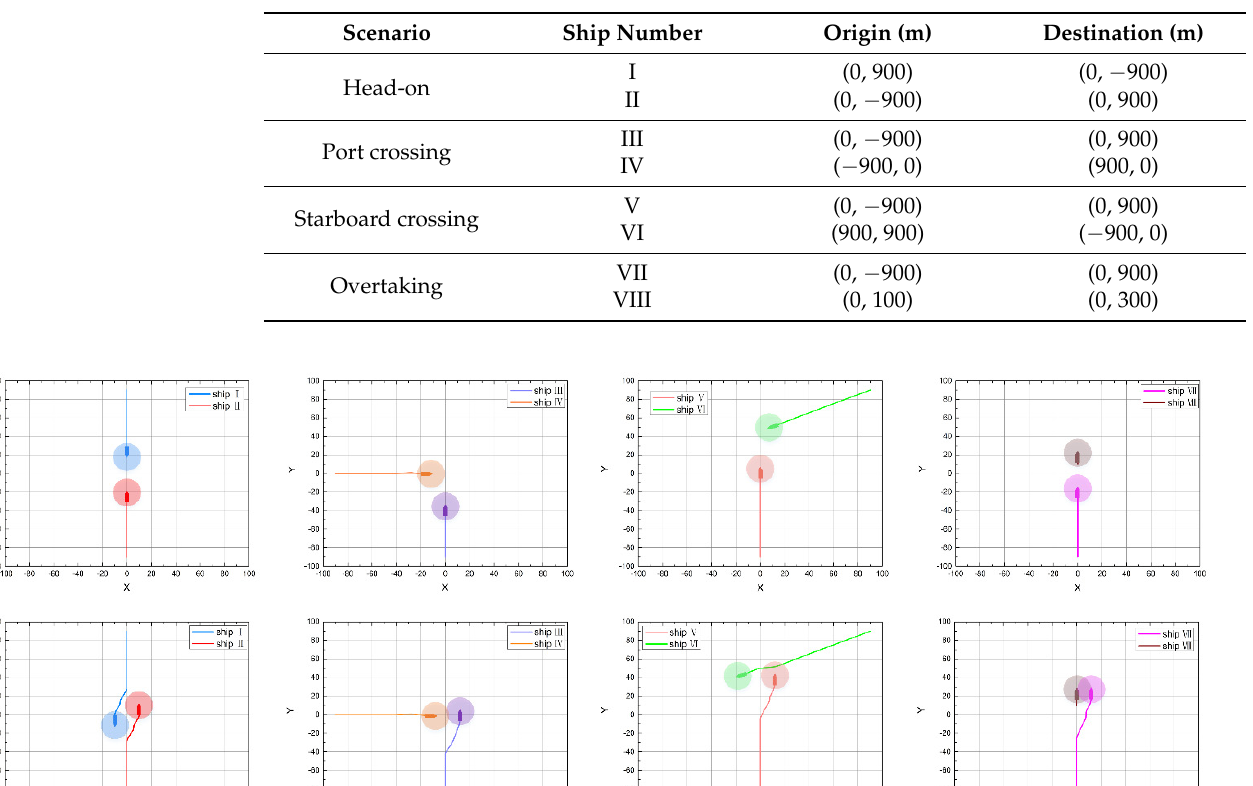
Table 4. Two ships test parameters.